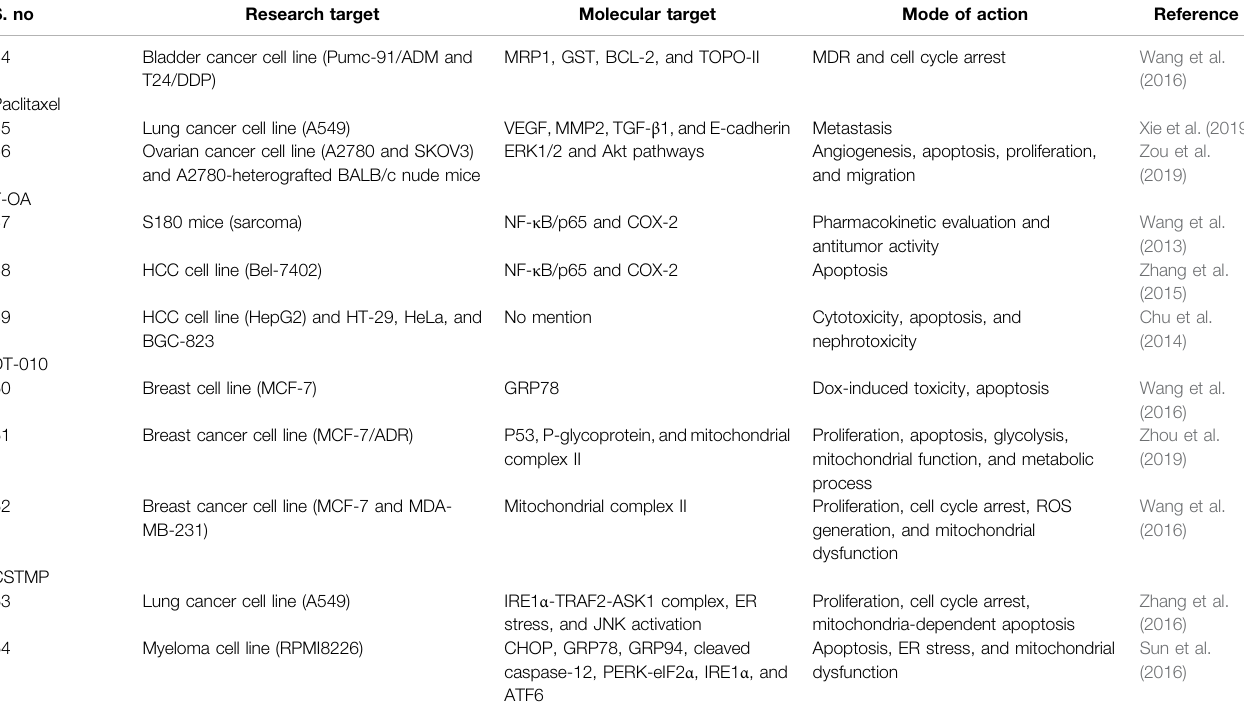
TABLE 2 | ( Continued ) Antitumor effect of tetramethylpyrazine against the tumor models of multiple